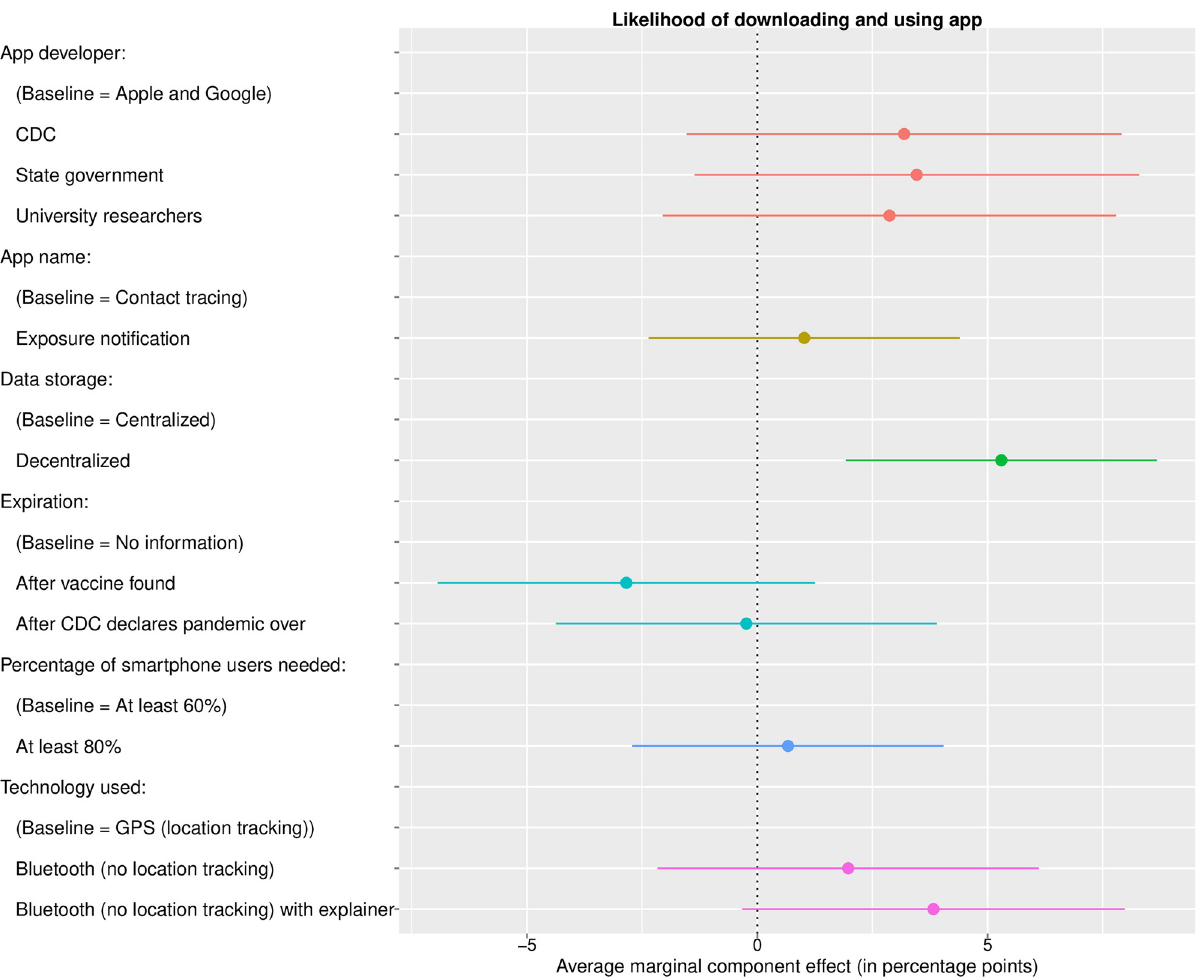
Fig 4. Average marginal component effects of contact tracing app attributes on reported likelihood of downloading and using the app with 95% confidence intervals. Respondents were shown a description of a hypothetical contact tracing app that varied along six attributes. The value shown for each attribute was selected randomly. Respondents were then asked how likely they would be to download and use the app described. This outcome is measured using a continuous scale from 0 to 100. The question was asked of all respondents who reported owning a smartphone ( N = 1, 883). Coefficients depicted in the plot indicate the average marginal component effect of being shown a particular value of an attribute, compared to a baseline category, on the reported likelihood of downloading the app.